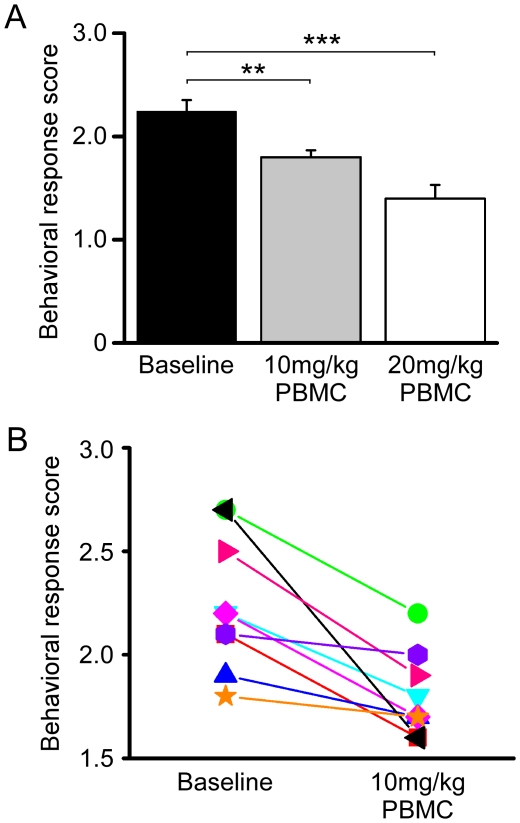
PBMC reduces acute cold-evoked behavioral responses.
A) In the acetone evaporative cooling assay, wildtype mice exhibited an average response score of 2.2±0.1, while treatment with 10 mg/kg PBMC reduced this score to 1.8±0.1 (Student's t-test, **p<0.01 vs. baseline) and treatment with 20 mg/kg PBMC reduced it further to 1.4±0.1 (Student's t-test, ***p<0.001 vs. baseline). B) Every mouse given 10 mg/kg PBMC showed a decrease in acetone response scores ranging from 0.1 (orange stars, violet hexagons) to 1.1 (black triangle).